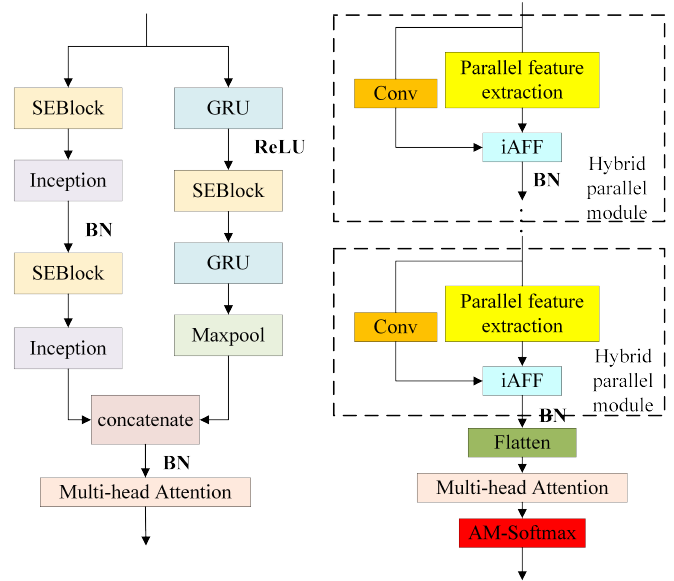
Figure 2. The structure of the hybrid parallel network ( a ) The parallel feature extraction module which is the basic component of the hybrid parallel module. ( b ) The structure of the hybrid parallel network which is composed of several the hybrid parallel